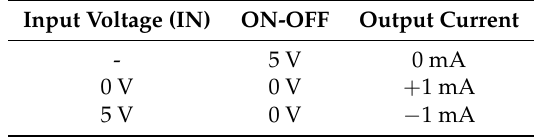
Table 2. Differential current driver IN/OUT reference